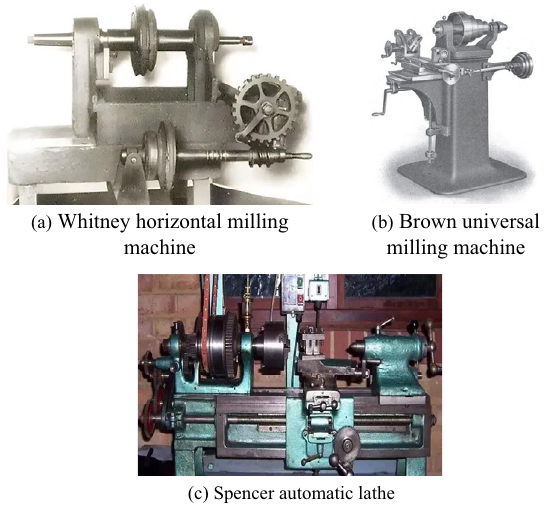
Figure 4 Typical machine tools in early electrification age [11]